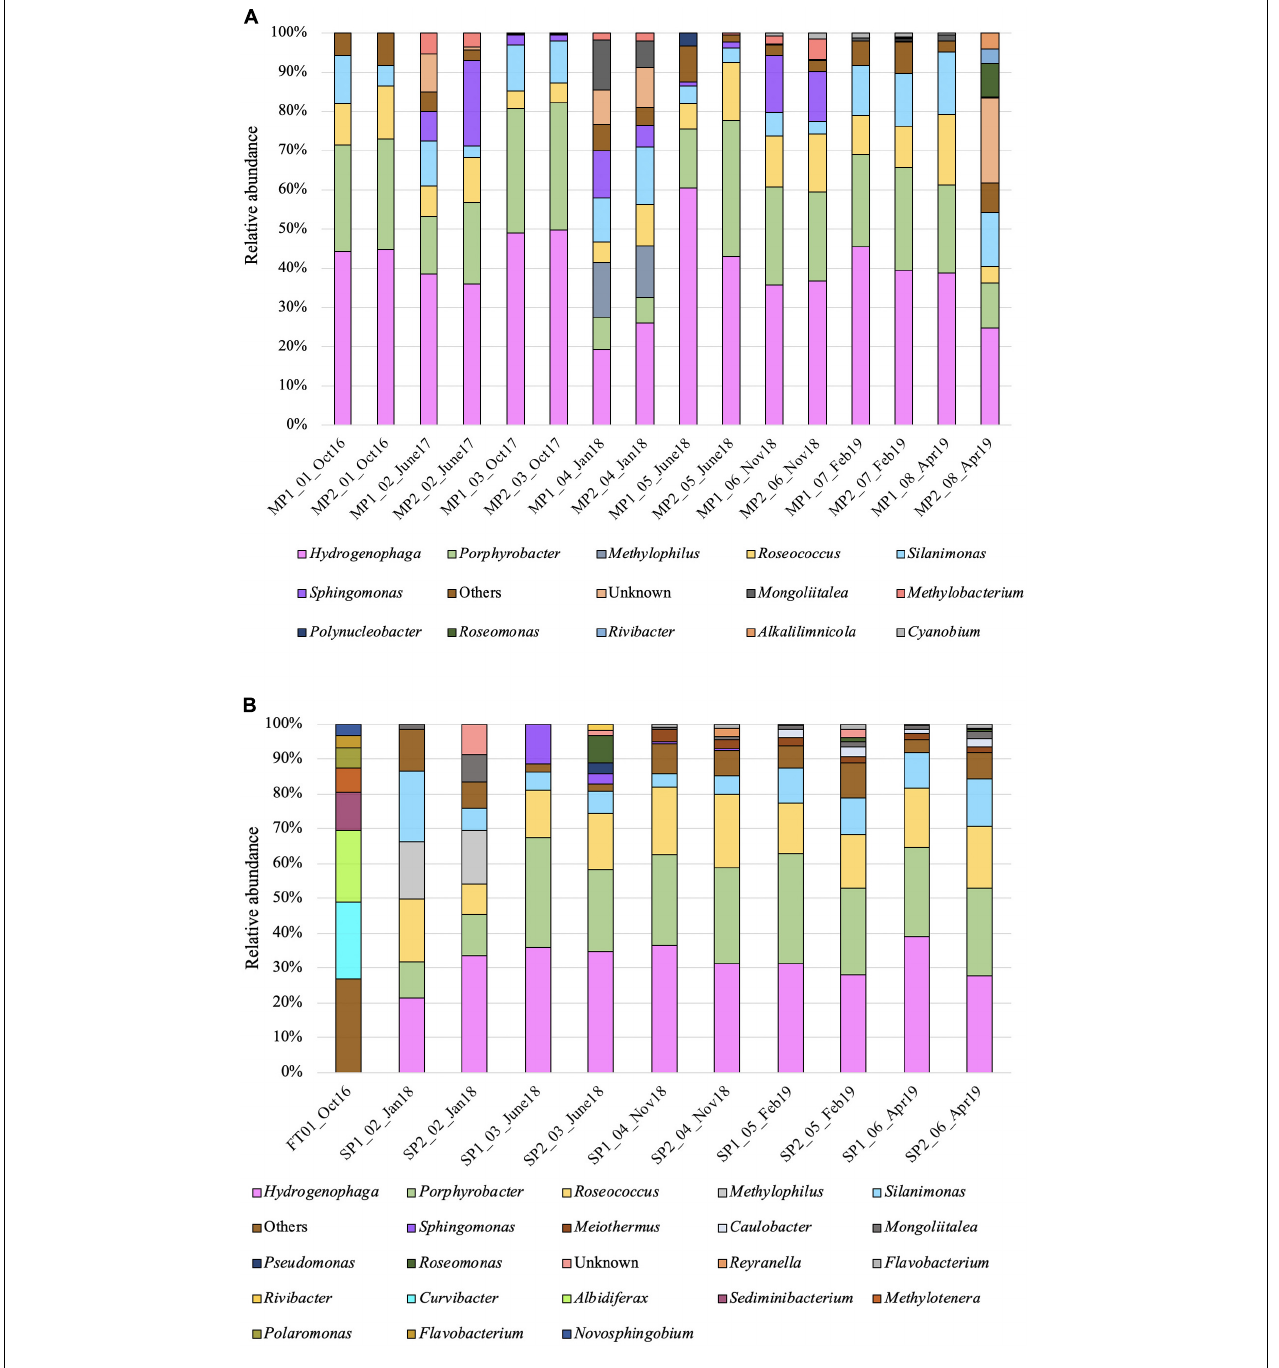
FIGURE 3 | Phylogenetic affiliations (closest known genera) of microorganisms detected in the indoor nuclear pond (INP) at Sellafield: (A) microbial community in the main pond (MP); (B) microbial community in the feeding tank (FT) and subponds (SP), based on Illumina sequencing of the prokaryote 16S rRNA gene. Only genera that contained more than 1.5% of the total number of sequences are